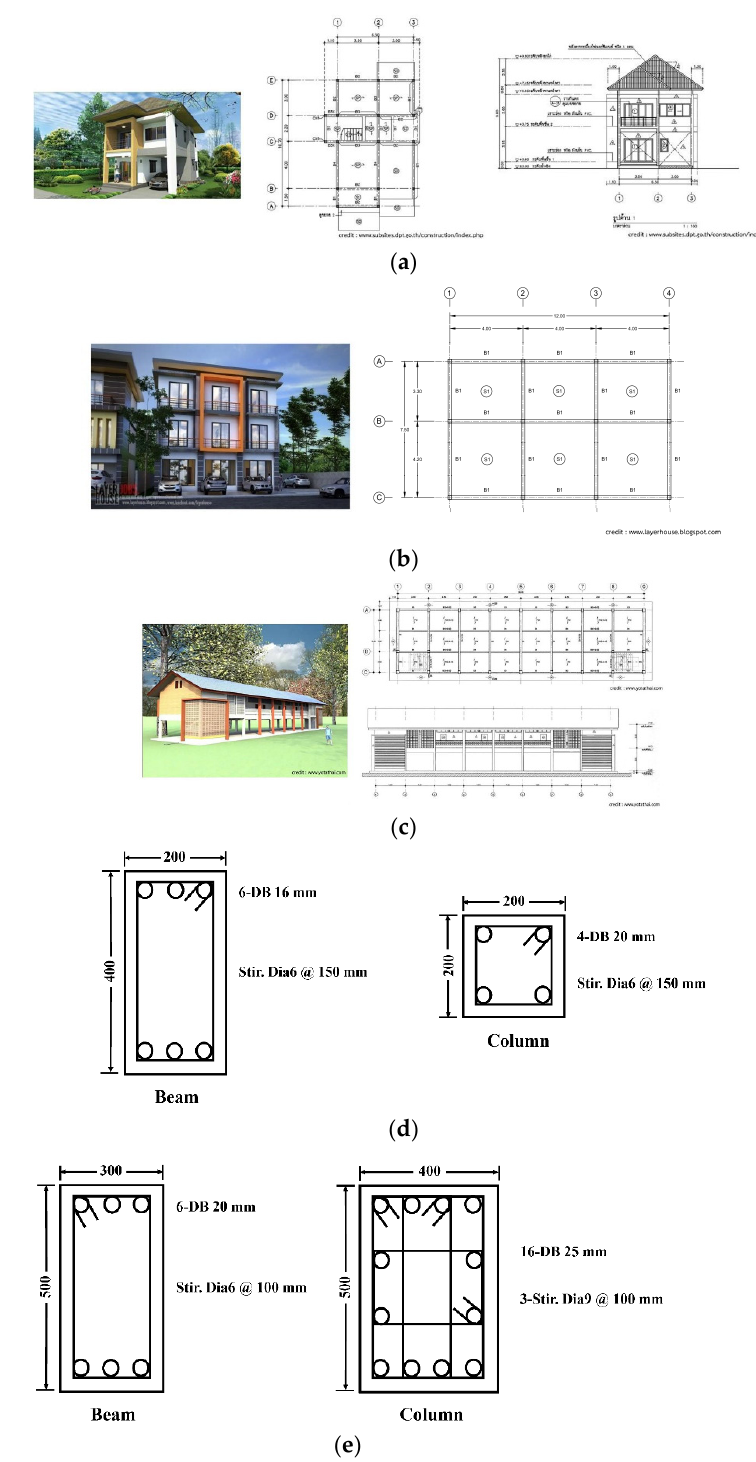
Figure 8. Structural drawing and cross-section of beams and columns for representative buildings: ( a ) residential building (RES); ( b ) commercial building (COM); ( c ) educational building (EDU); ( d ) RES and COM buildings; ( e ) EDU building . Table 4. Structural properties of representative